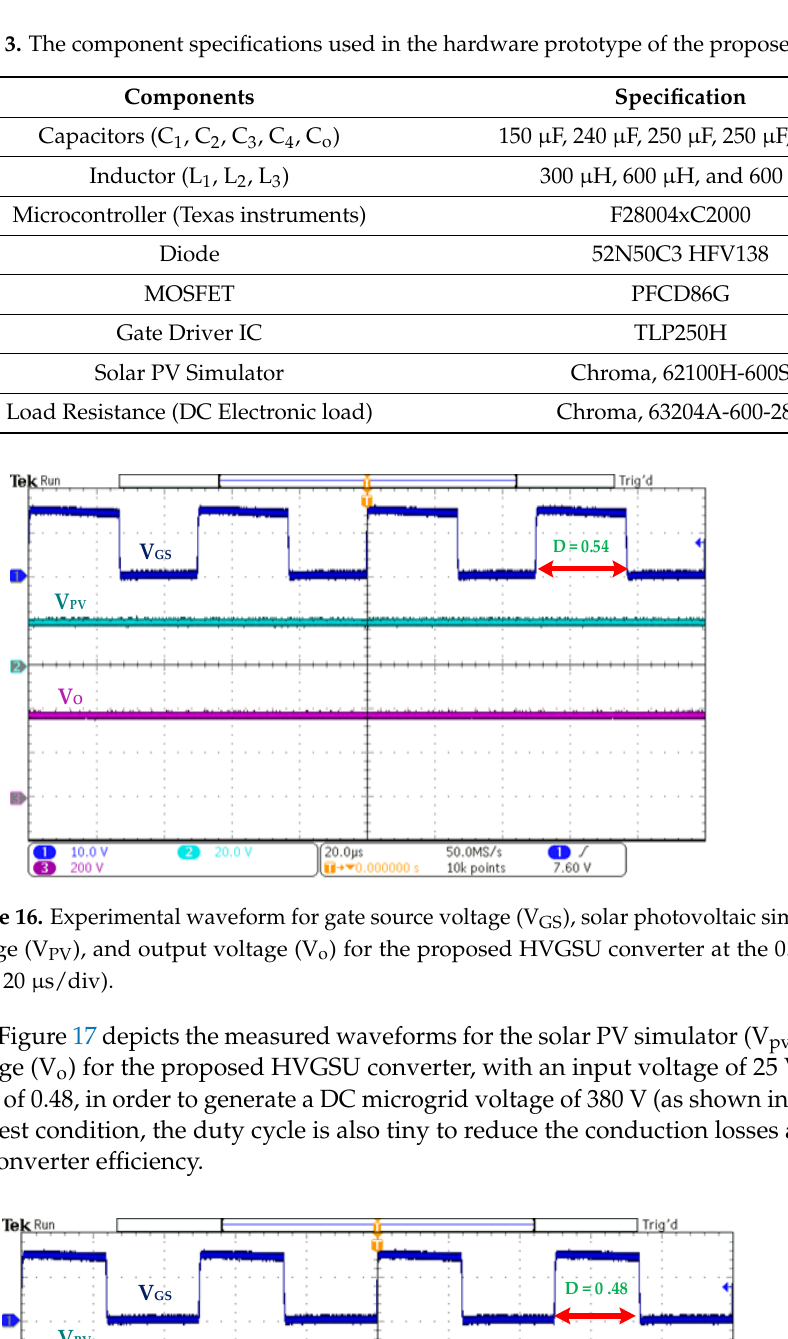
D = 0.44 V GS V PV V O Figure 18. Experimental waveform for the gate source voltage (V GS ), solar photovoltaic simulator output voltage (V PV ), and output voltage (V o ) for the proposed HVGSU converter at the 0.44 duty cycle (Hor: 20 µs/div). Figure 19 shows the measured waveforms for the solar PV simulator (V pv ) and output voltage (V o ) for the proposed HVGSU converter, with an input voltage of 35 V and a duty cycle of 0.39, in order to generate a DC microgrid voltage of 380 V (as shown in Figure 1). Under these conditions, the duty cycle is small, reducing the conduction losses and raising the converter efficiency.